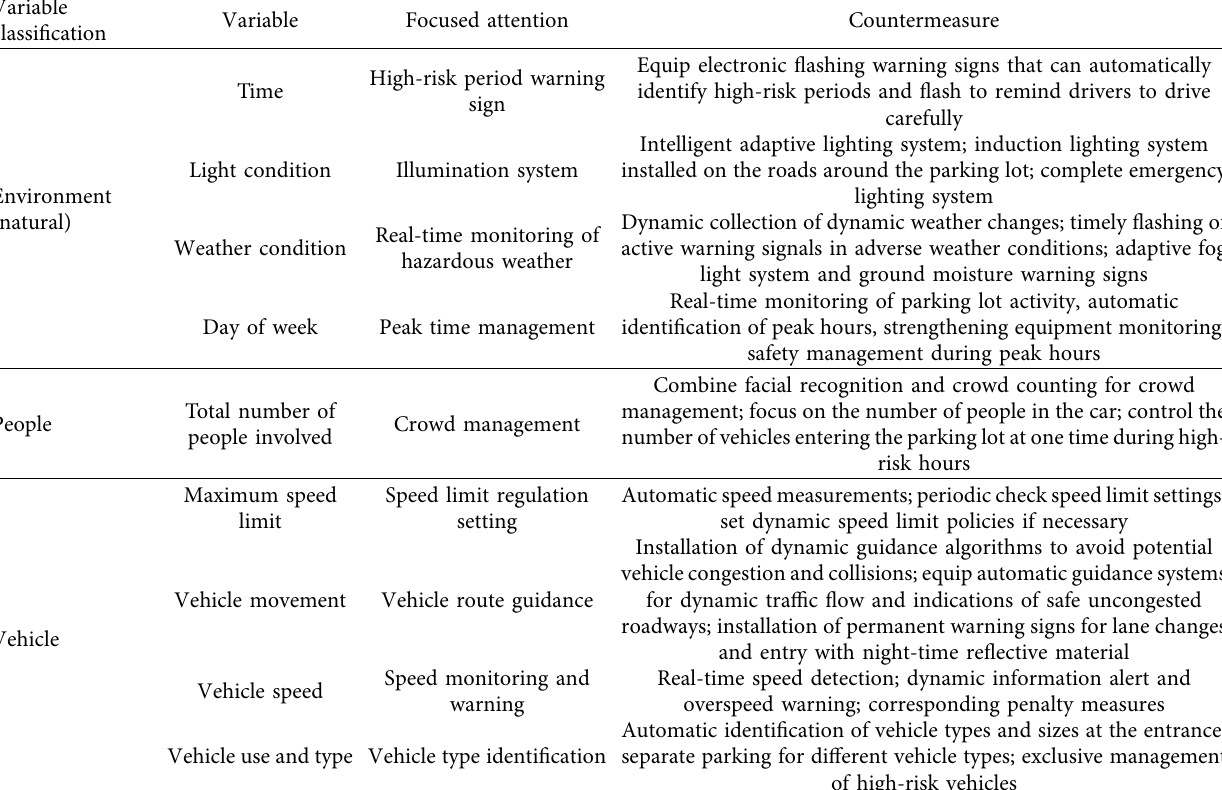
Table 8: Library of focused attention on controllable variables and corresponding measures.